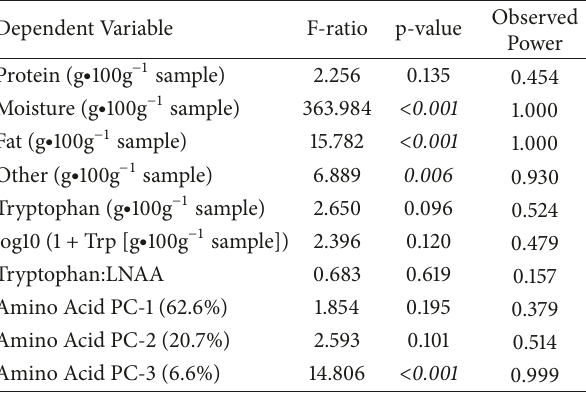
Table 8: 1-Way ANOVA Comparing Types of Processed Meat.